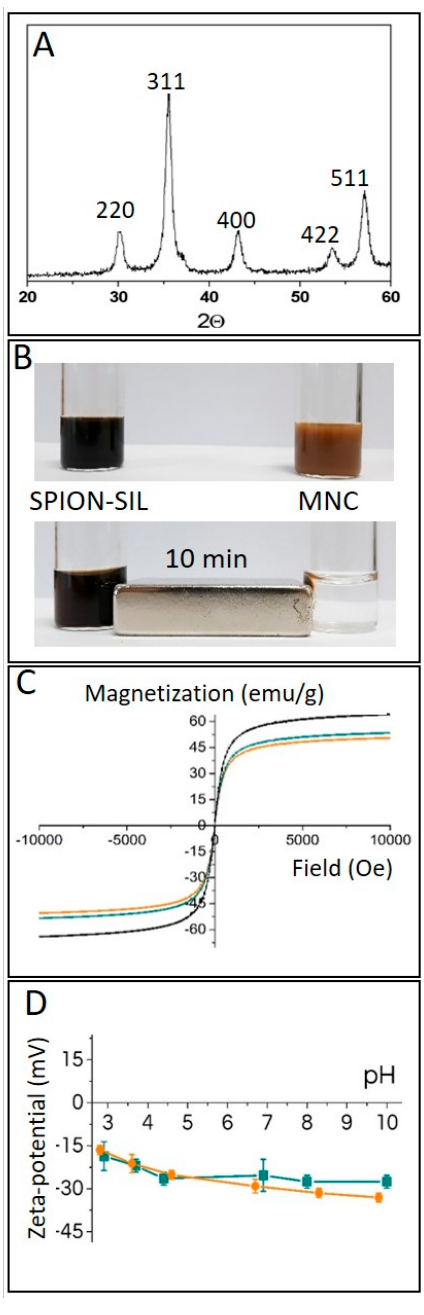
Figure 2. ( A ) The XRD pattern of iron oxide nanoparticles. ( B ) Photographs representing e ffi cient magnetic separation of silica-encapsulated nanoparticle clusters (MNC), whereas silica-encapsulated individual nanoparticles (SPIONs-SIL) are not magnetically responsive. ( C ) The room temperature measurements of the specific magnetization as a function of the magnetic field for the SPIONs (black), silica-encapsulated nanoparticles (SPIONs-SIL) (orange), and MNCs (cyan). ( D ) The change of the ζ potentials of the (SPIONs-SIL) (orange) and MNCs